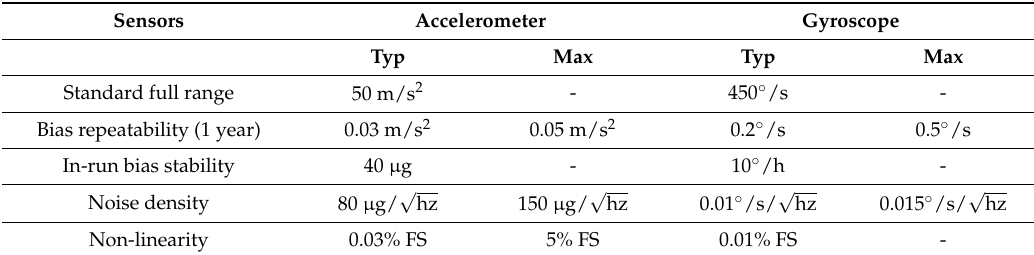
Table 1. The performance parameters of